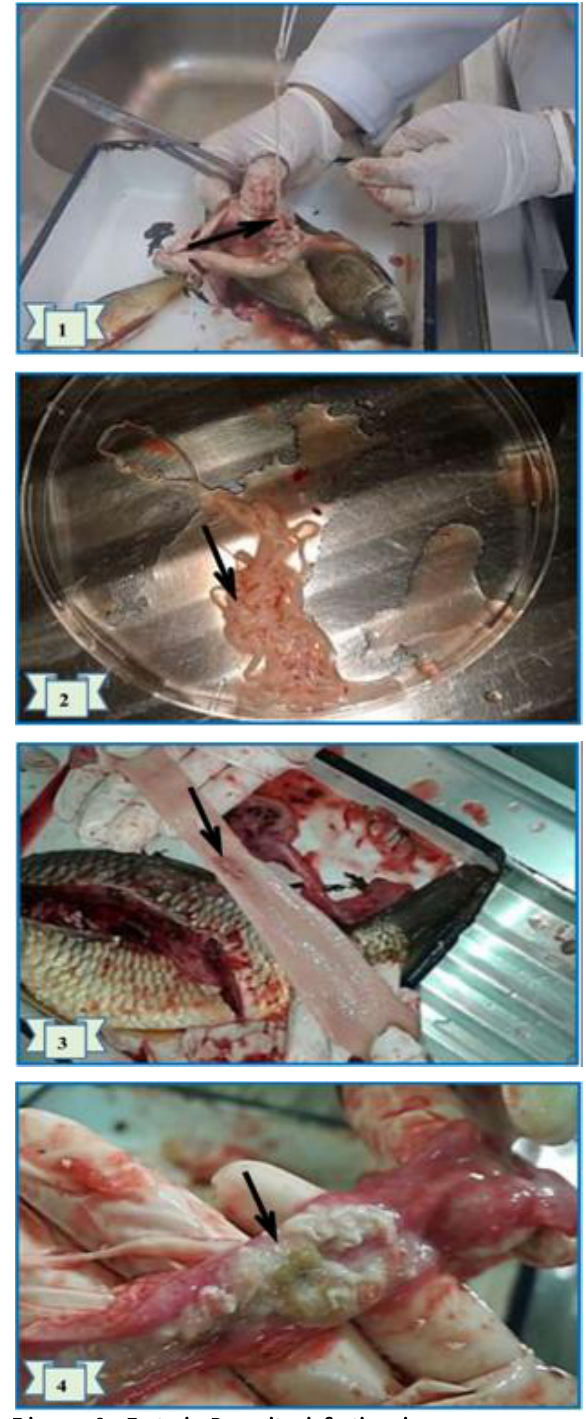
Figure, 8: Enteric Parasite infection in common carp. Grossly [1] there is huge number of tapeworms inside the intestines (arrow), which [2] its length reaches up to meter (arrow), in other cases [3] there is nodular lesion in intestine (arrow) contain trematodes of 2 centimeters in length, in other cases [4] there is lesions in intestines contains tapeworms covered with fibrous membrane